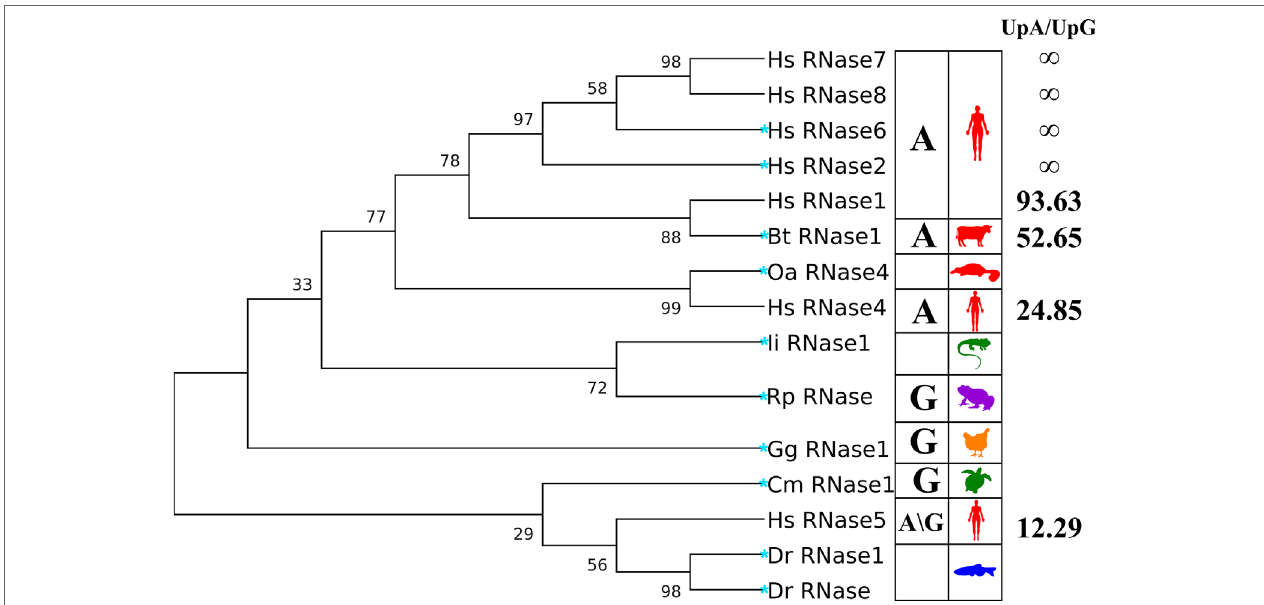
FIGURE 2 | Phylogenetic tree of the RNases studied in the kinetic and molecular dynamics analysis. Right column indicates the UpA/UpG preference ratio according to kinetic results (see Table 1 ). Left column includes the A/G preference at B2 according to the literature. The evolutionary history tree was inferred by using the maximum likelihood method and JTT matrix-based model (Jones et al., 1992). The tree with the highest log likelihood (−3745.36) is shown. The percentage of trees in which the associated taxa clustered together is shown next to the branches. Initial tree(s) for the heuristic search were obtained automatically by applying Neighbour-Join and BioNJ algorithms to a matrix of pairwise distances estimated using a JTT model, and then selecting the topology with superior log likelihood value. The tree is scaled, with branch lengths measured as the number of substitutions per site. Evolutionary analyses were conducted in MEGA X (Kumar et al., 2018). A more complete phylogenetic tree of RNase A family members is included in Figure S2 . Blue star highlights the selected representative RNases to perform MD simulation